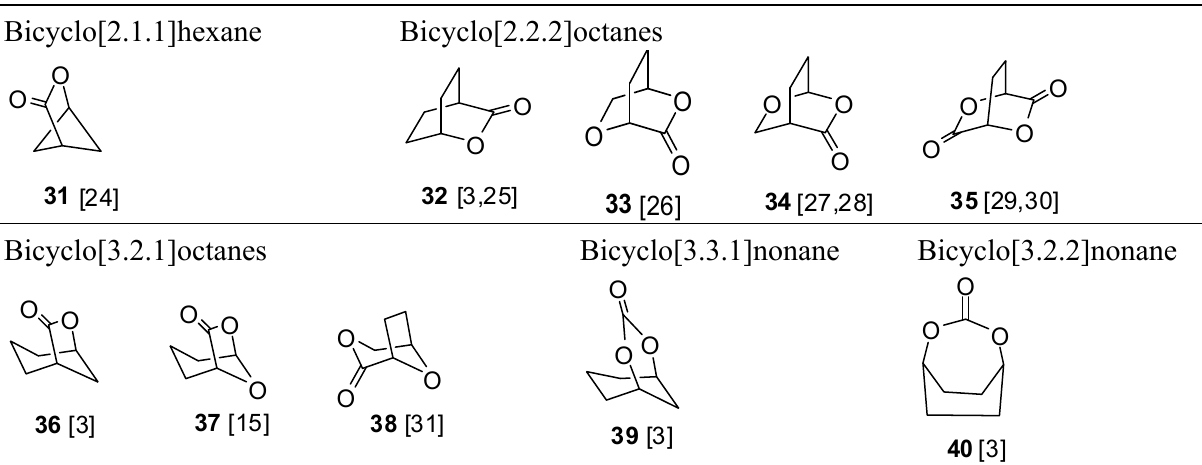
Table 4. Bicyclic lactone and carbonate monomers 31–40 [3,15,24–31].